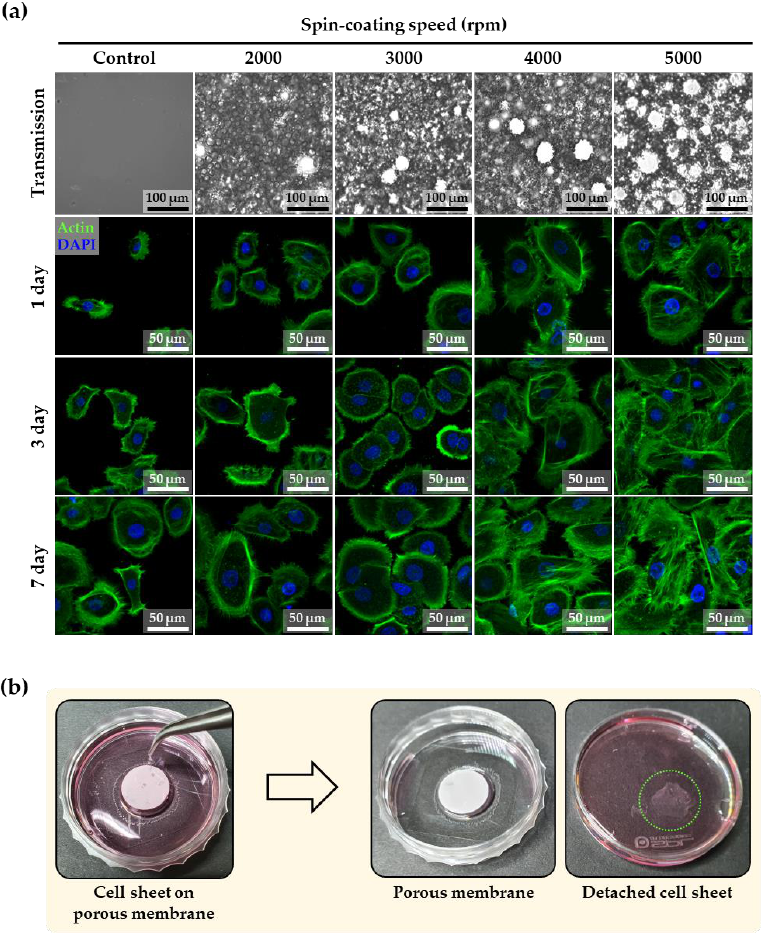
Figure 5. ( a ) Immunofluorescent images of actin and DAPI staining of keratinocyte cells on the PDMS membrane at days 1, 3, and 7 according to spin-coating speed. ( b ) Images before and after the detachment of cell sheet from the porous PDMS membrane (spin-coating speed of 5000 rpm) at day 7.